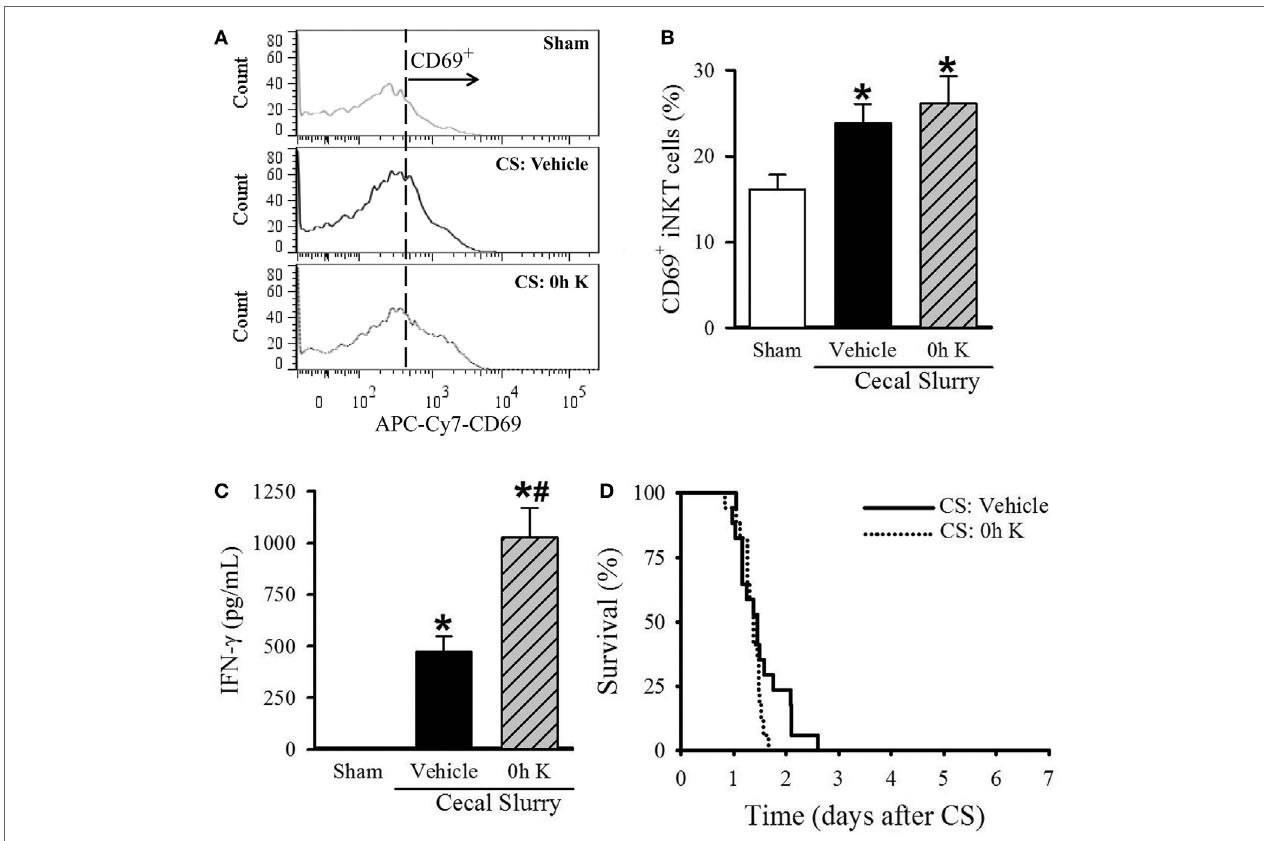
FigUre 3 | Effect of 0 h KRN treatment on invariant natural killer T (iNKT) cell activation and survival in septic neonatal mice. Sepsis was induced in neonatal C57BL/6 pups by intraperitoneal (i.p.) injection of cecal slurry (CS, 0.9 mg/g BW). Pups then received KRN (0.2 µg/g BW) or vehicle (2.5% dimethyl sulfoxide in PBS) i.p. within 1 h. Serum and liver were harvested 10 h later. (a) Representative histogram of CD69 expression on hepatic iNKT cells. (B) Flow cytometric analysis of surface CD69 expression on gated hepatic iNKT cells. (c) Interferon (IFN)- γ levels in the serum were measured by enzyme-linked immunosorbent assay.